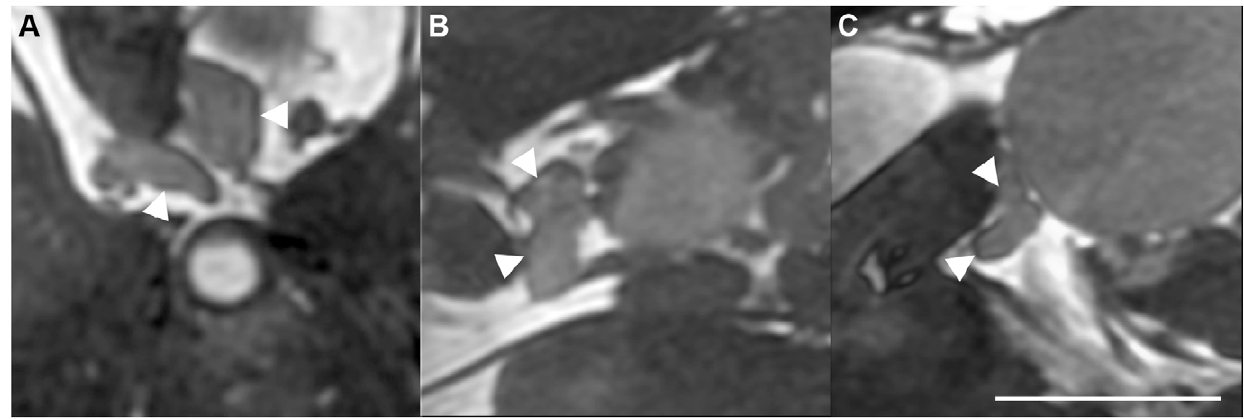
Figure 4. 3 views of prostate from one in-vivo scan. A: axial, B: coronal, C: sagittal. White arrows indicate prostate. Scale bar is 0.5 cm. Axial scan, FOV 3 6 3 cm, 200 m m isotropic resolution, TR/TE=4.6 ms/2.3 ms, 4 PC, 2 NEX, FA 50 u , BW 6 62.5 kHz, 14 minutes.